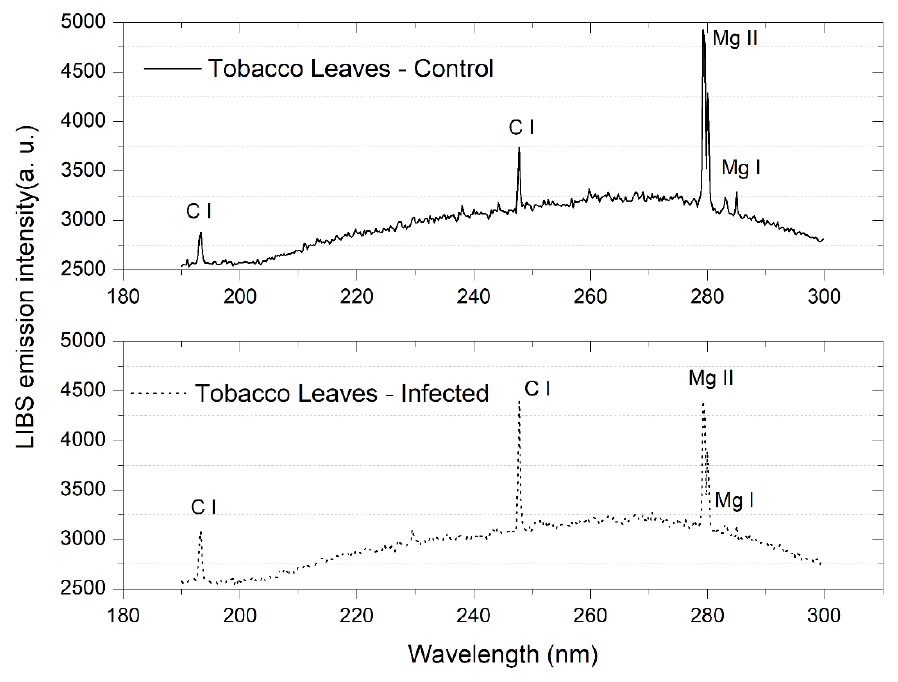
Figure 9. LIBS spectra of control and infected tobacco